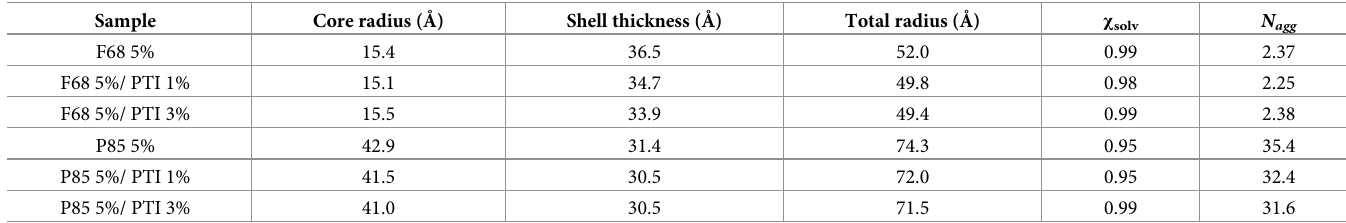
Table 6. Geometric parameters from model-fitting of the SANS Pluronic data at 37˚C, including core and shell micellar sizes, fraction of solvent in the corona ( χ solv ) and aggregation number ( N agg ). (Also see Fig E in S1 File).